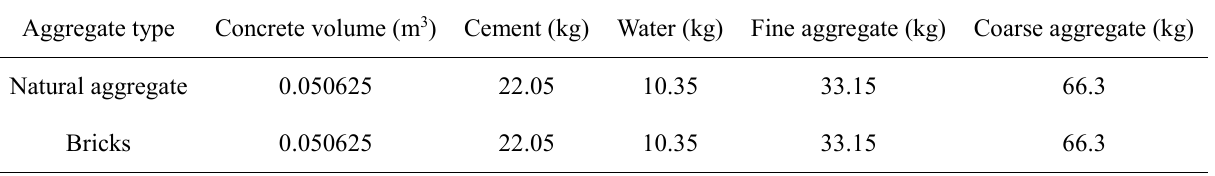
Concrete batching for grade 20 concrete (natural aggregate and